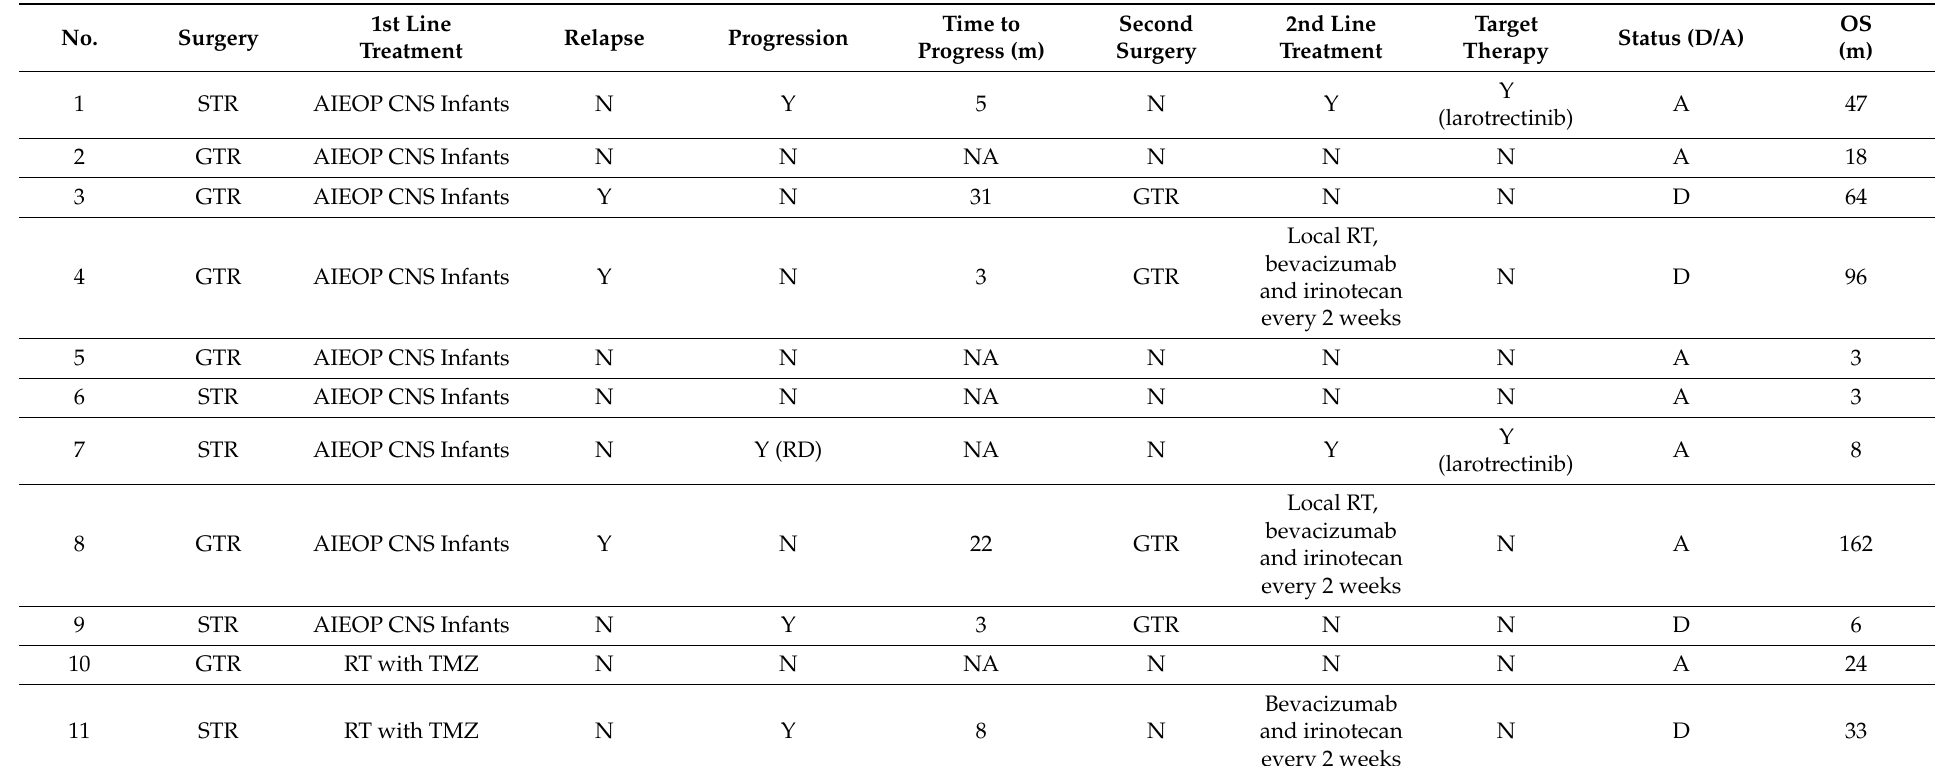
Table 2. First and second-line